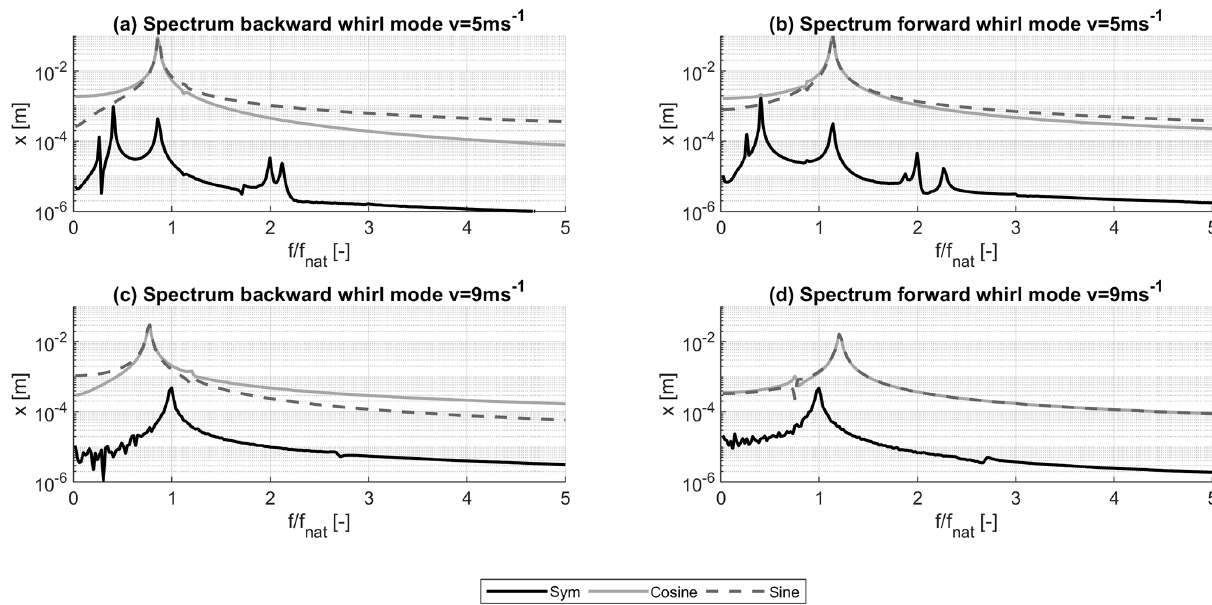
Figure 1. Spectrum of the in-plane displacements from time series at 5ms − 1 (a, b) and 9ms − 1 (c, d) for the fully flexible upwind turbine configuration in Coleman coordinates (coordinates of the fixed frame of reference; see also Sect. 2.2) for the backward whirl mode (a, c) and the forward whirl mode (b, d) . The frequency axis is normalized with the blade edgewise natural